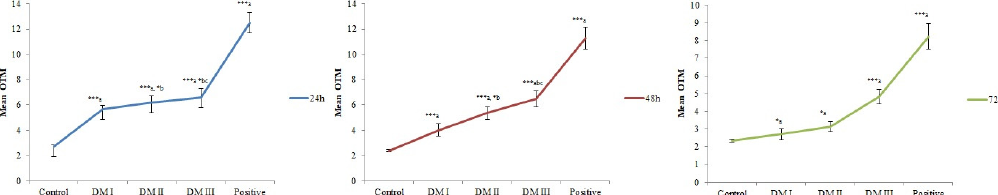
Figure 3. Concentration dependent relationship graphs. Showing the consequence of Dimethoate intoxication on Olive tail moment (OTM) of the comet with increasing doses at multiple time periods assessed by comet assay in rat blood cells. Significant values at * p < 0.05; *** p < 0.001 (One way ANOVA, post hoc Tukey); a (compared to normal control); b (compared to DCV I); c (compared to DCV II); Control (2 mL/kgbw); Positive (40 mg/kgbw CPA); DM I (10 mg/kgbw); DM II (20 mg/kgbw); DM III (30 mg/kgbw).